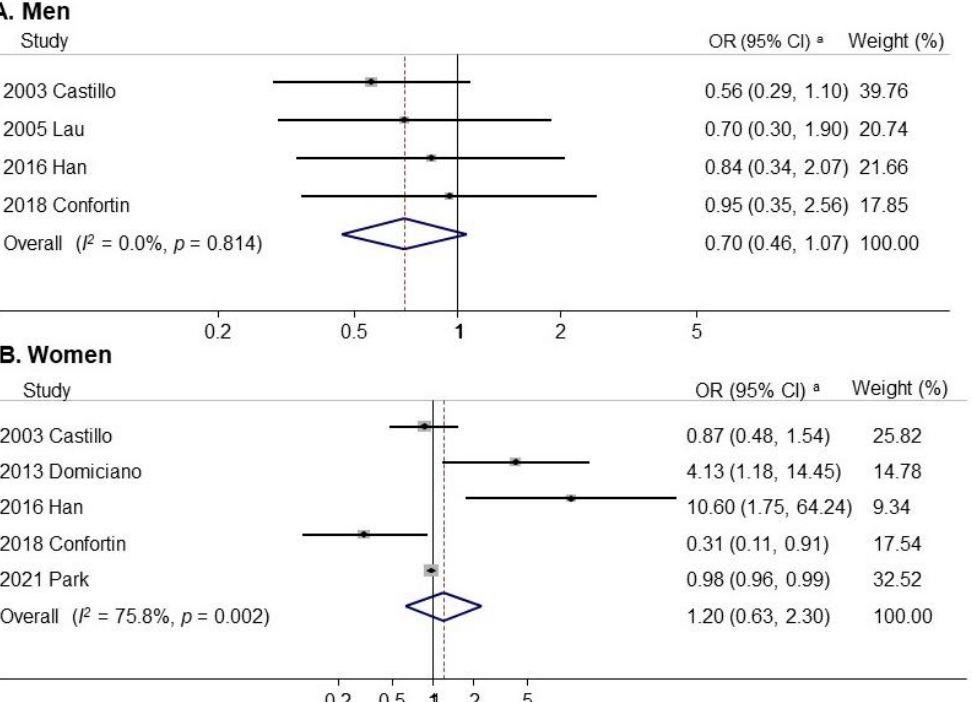
Figure 4. Funnel plots for identifying publication bias in the meta-analysis of observational studies. Abbreviations: OR, odds ratio; SE, standard error.